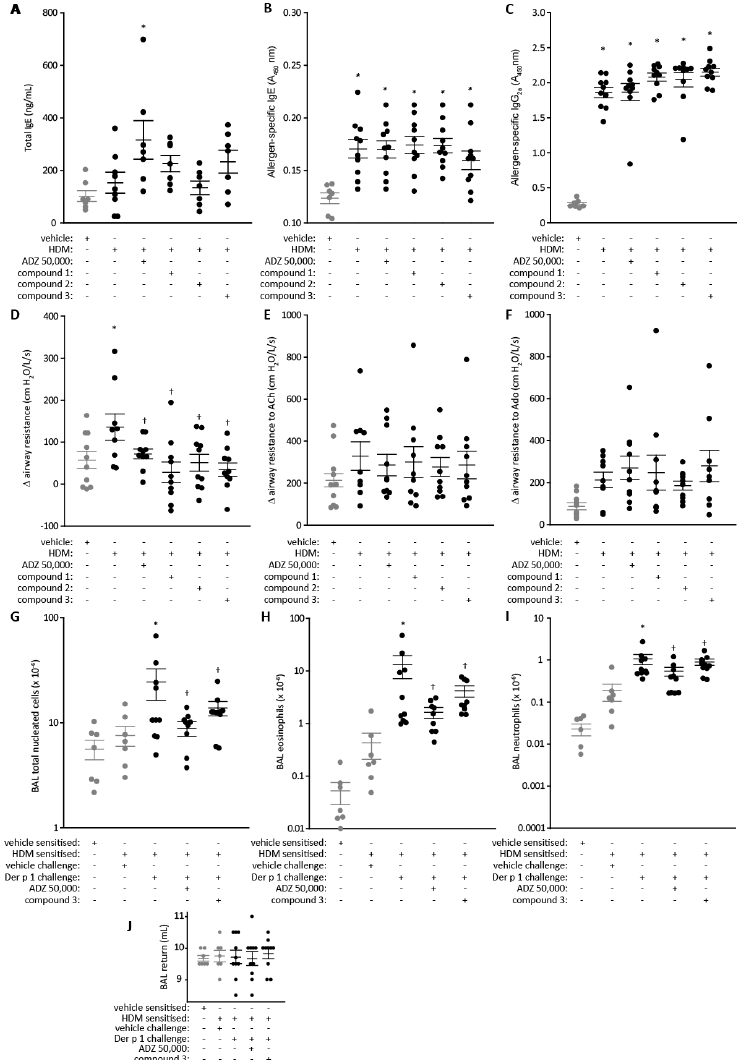
Figure 4. Effects of allergen delivery inhibitors on airway responses to either an extract of mixed HDM allergens or Der p 1 in brown Norway rats. ( A – C ) Post-sensitisation serum concentrations of IgE, allergen-specific IgE and allergen-specific IgG 2a in animals assigned to the treatment groups for the lung function investigations performed in ( D – F ). Assignment to drug treatment was made blind with respect to these data which were obtained after the conclusion of the lung function studies. * p < 0.001–0.05 vs. control animals assigned to sham sensitisation with vehicle (shown in grey). ( D ) Changes in airway resistance following challenge of HDM-sensitised animals with an i.t. aerosol of mixed HDM allergens (10 µ g Der p 1 equivalent) or vehicle. Animals were treated with ADZ 50,000 ( × 10 molar ratio to Der p 1), Compound 1 ( × 250 molar ratio to Der p 1), Compound 2 ( × 200 molar ratio to Der p 1), Compound 3 ( × 8 molar ratio to Der p 1) prior to HDM challenge. * p < 0.05 vs. control animals assigned to sham sensitisation and challenge with vehicle (data shown in grey). † p < 0.01–0.05 vs. challenged with mixed HDM allergens. ( E , F ) Changes in airway resistance to acetylcholine and adenosine, respectively, measured 1 h after allergen challenge in the six treatment groups. ( G – J ) BAL cell profiles and BAL fluid recovery in animals sensitised to mixed HDM allergens and challenged with Der p 1 (10 µ g in 100 µ L) with or without prior treatment with ADZ 50,000 ( × 2.5 molar ratio to Der p 1) or Compound 1 ( × 8 molar ratio to Der p 1). * p < 0.01–0.05 vs. control animals assigned to sham sensitisation and challenge with vehicle or vehicle challenge in animals sensitised to mixed HDM (data shown in grey). † p < 0.05 vs. animals challenged with Der p 1. Data are shown as results for individual animals with mean ± s.e. indicated by cross-hair and